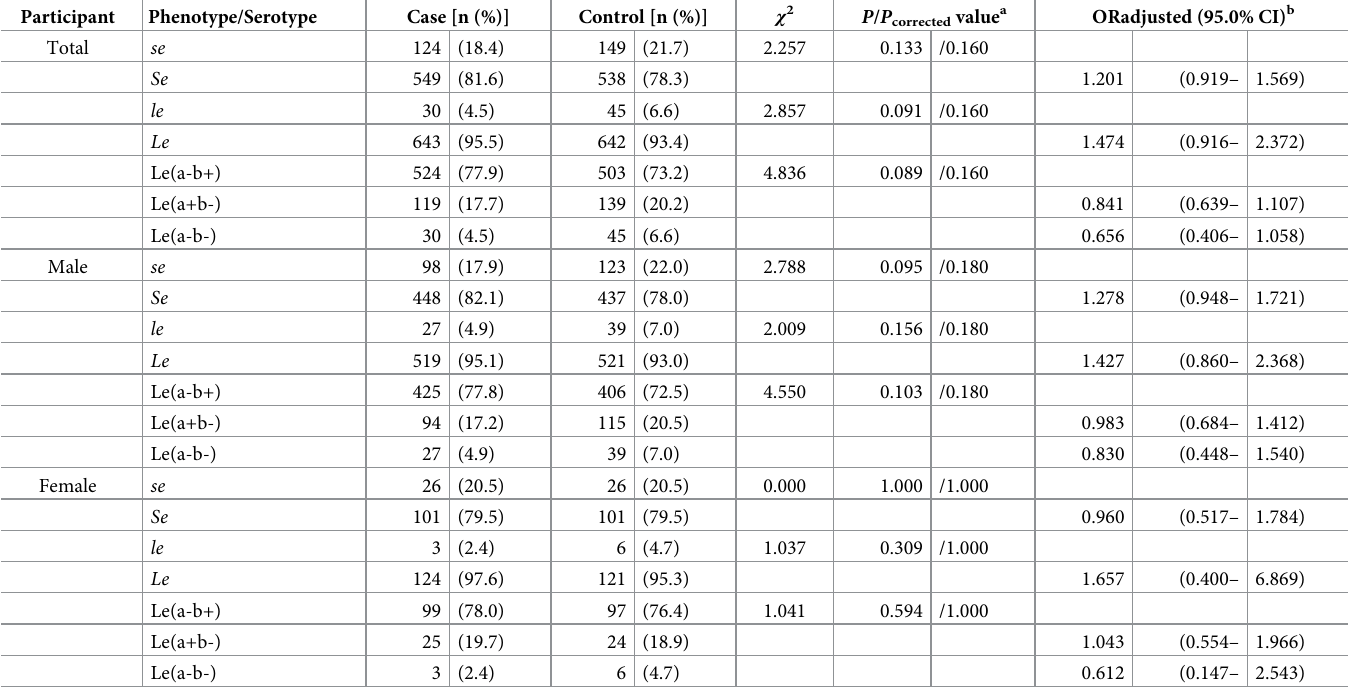
Table 4. Frequency differences in FUT2/FUT3 phenotypes between cases and